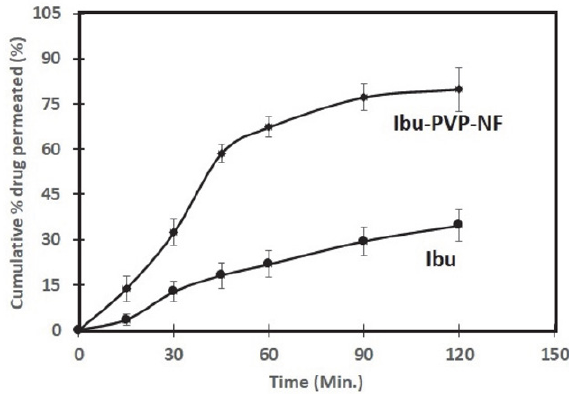
Fig 5. Ex vivo intestinal permeation pattern of raw ibuprofen (Ibu) and nanofiber (Ibu-PVP-NF)